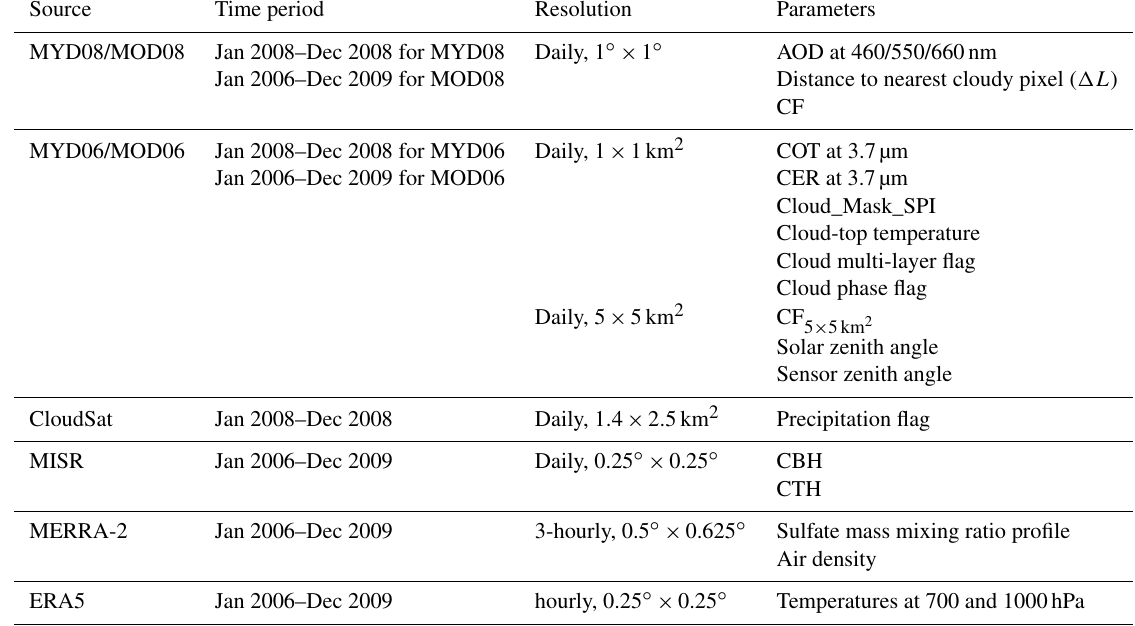
Table 1. The list of the parameters, sources, and their corresponding temporal–spatial resolutions applied in the present study. Source